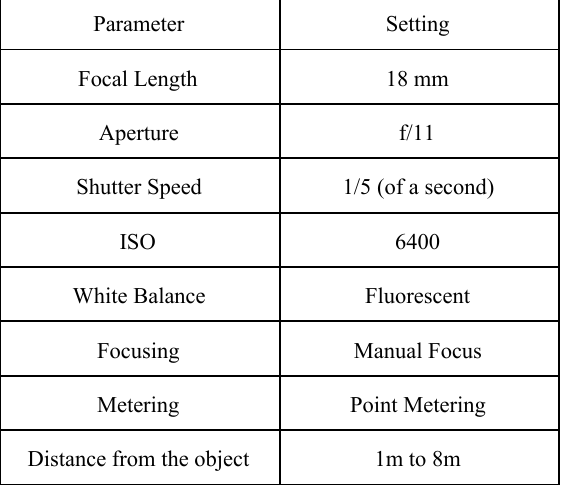
Table 3. DSLR camera used throughout